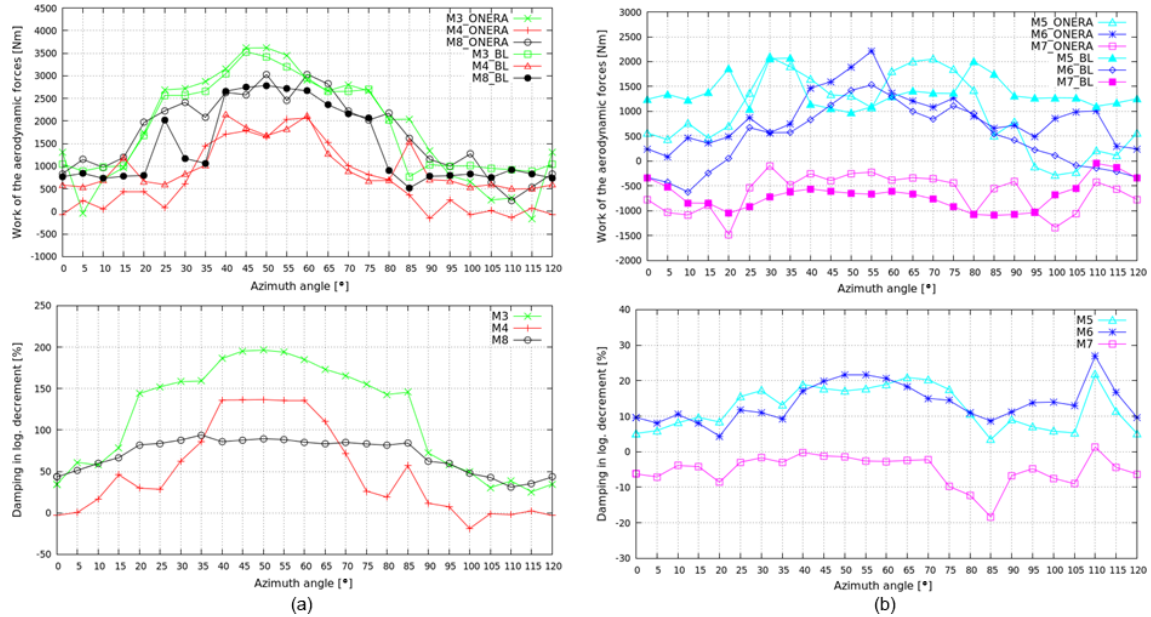
Figure 26. Comparison between aerodynamic work (0.2m modal amplitude) and damping results versus azimuth angle for unsteady aero- dynamics (ONERA and BL model); U = 42 . 5ms − 1 and yaw = 30 ◦ . (a) In-plane (flapwise) modes and (b) out-of-plane (edgewise